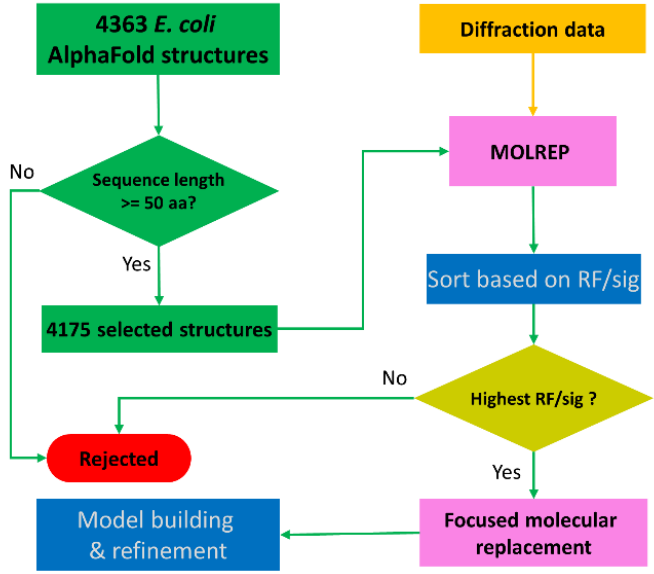
Figure 1. Schematic workflow of sequence-independent crystallographic phasing using AlphaFold- predicted E. coli structures. A total number of 4363 AlphaFold-predicted structures were down- loaded from the AlphaFold structure database. After filtering based on protein sequence length, 4175 structures were selected for molecular replacement using MOLREP. The output candidate so- lutions were sorted based on RF/sig, and the AlphaFold structure with the highest RF/sig peak height was selected for focused molecular replacement and downstream model building and refine- ment.